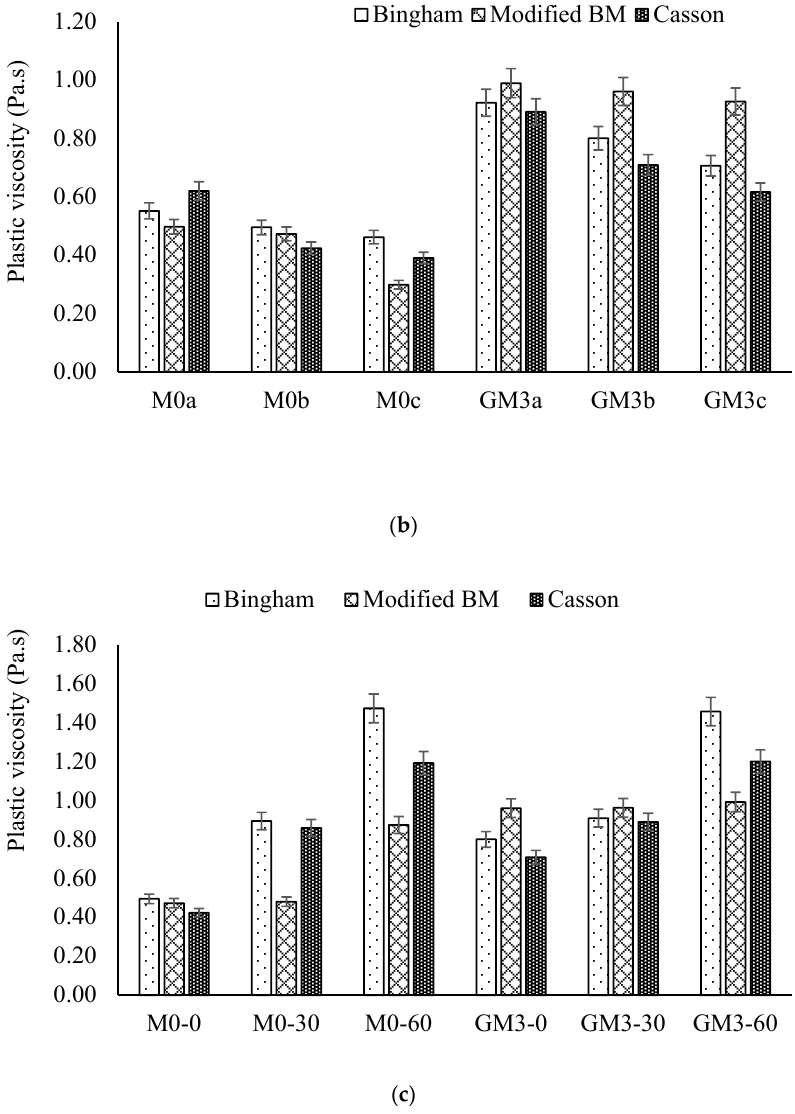
Figure 21. Plastic viscosity values (Pa · s) calculated by various mathematical models with varying ( a ) GNP amount, ( b ) shear rate and ( c ) resting time. Reproduced with permission from [118], MDPI, 2017.